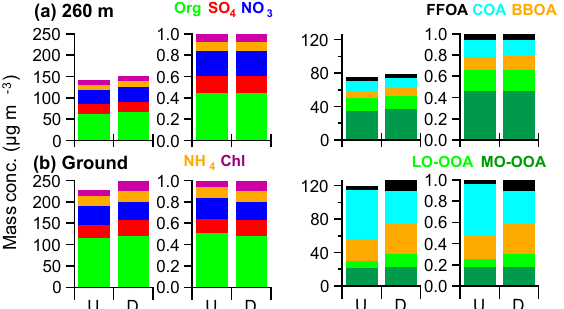
Figure 9. Average chemical composition of NR-PM 1 and OA at ground level and 260m for vertical profile 11 (V11). Right panels are the mass fractions of NR-PM 1 and OA species. “U” and “D” represent “up” and “down” experiment, respectively.